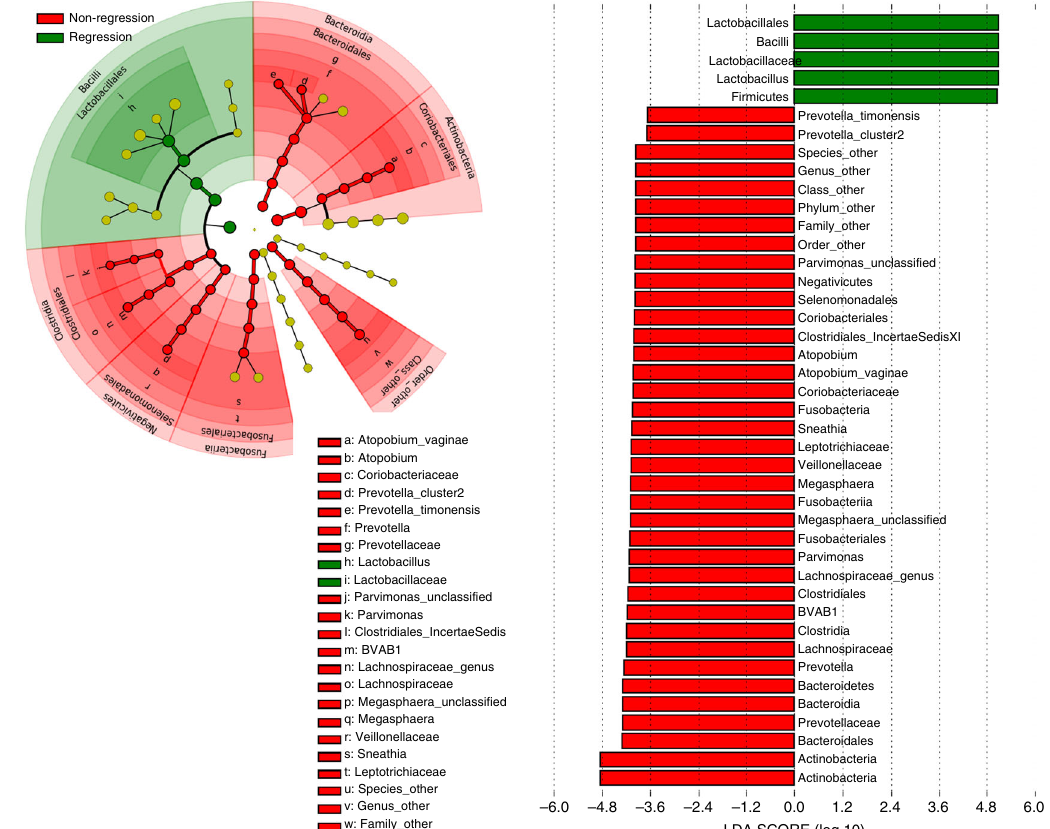
Fig. 5 LEfSe analysis identi fi ed baseline vaginal microbiota biomarkers associated with clinical outcomes at 12 months follow-up. a Cladogram representing taxa at all phylogenetic levels with signi fi cantly different abundance according to clinical outcome at 12-month follow-up. The size of the circle is proportional to the abundance of taxon represented. b Histogram of LDA scores found to differ signi fi cantly in abundance between those who regressed compared to those who did not regress. LDA linear discriminant analysis. Analysis restricted to top 20 taxa with all remaining taxa denoted as ‘ other ’ .